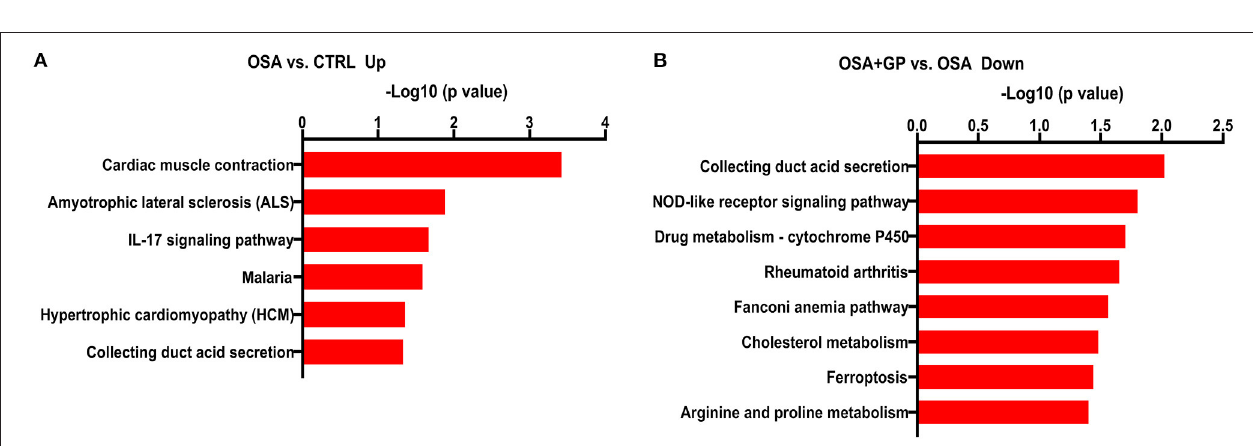
FIGURE 12 | The X -axis represents the –log10 ( p -value) showing the overrepresented pathways according to the identified differentially expressed genes for (A) OSA vs. CTRL (up expression) and (B) OSA + GP vs. OSA (down expression). The supplement that lists the specific genes for each pathway is also shown ( n = 3 animals per intervention); abbreviations as in Figure 1